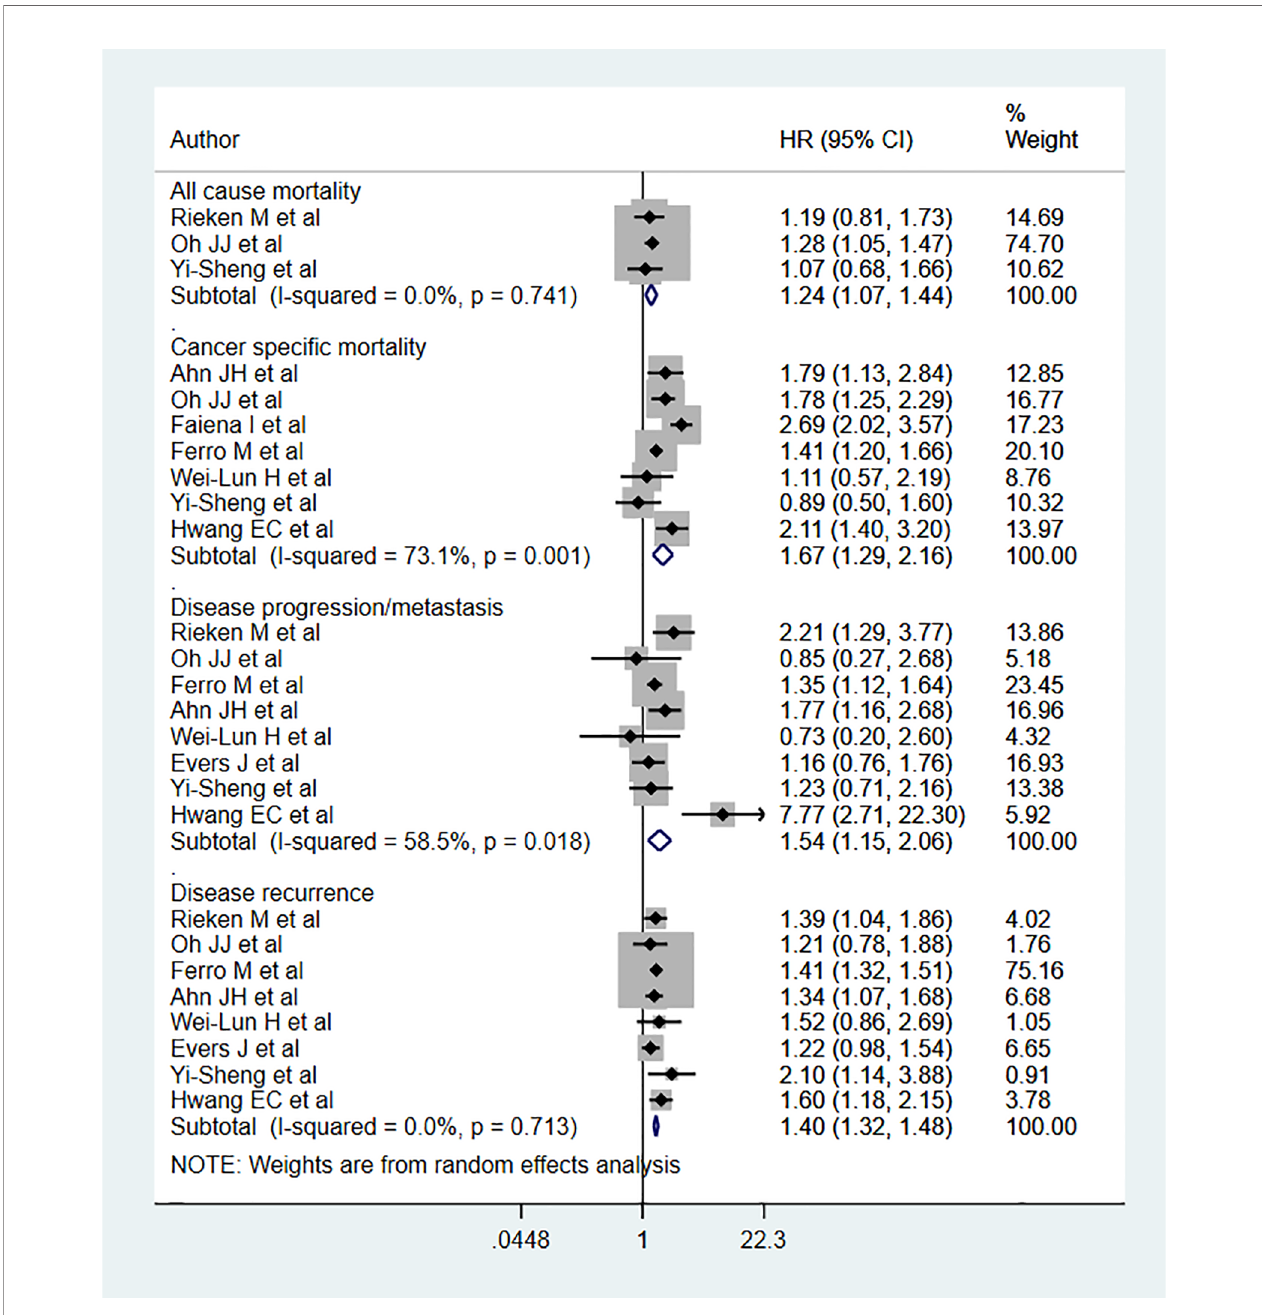
FIGURE 2 | Relationship between diabetes and bladder cancer